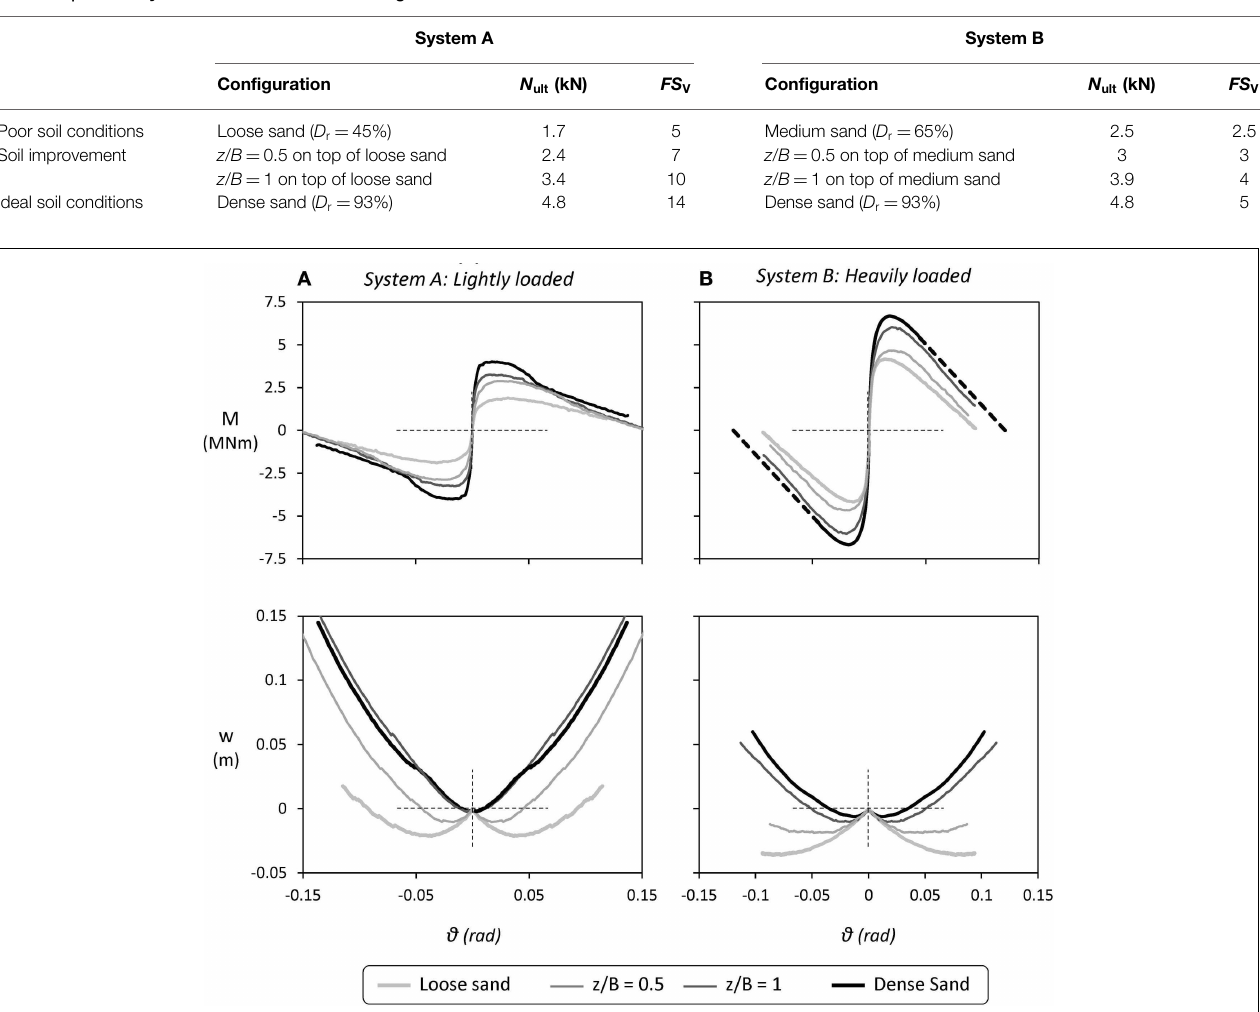
TABLE 1 | Summary of monotonic vertical loading .